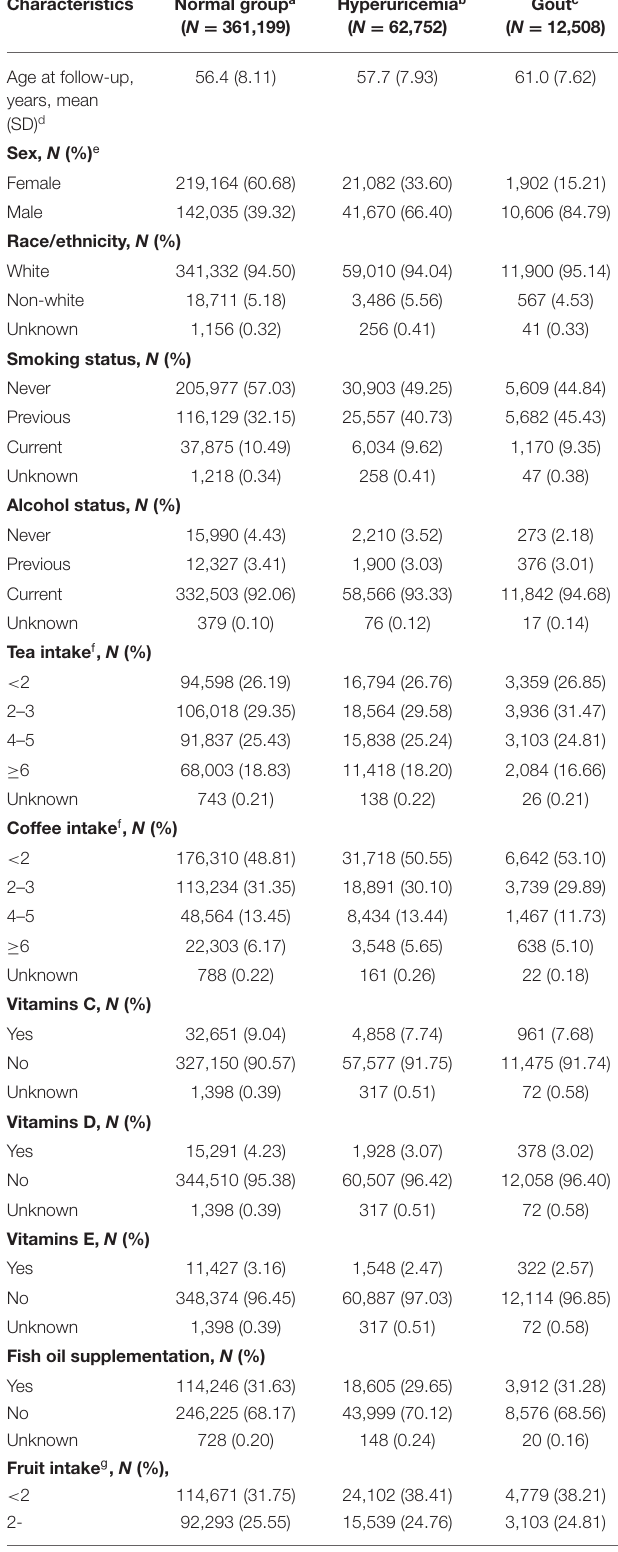
TABLE 1 | Baseline characteristics of study participants in a cohort study of 431,967 individuals from UK Biobank.